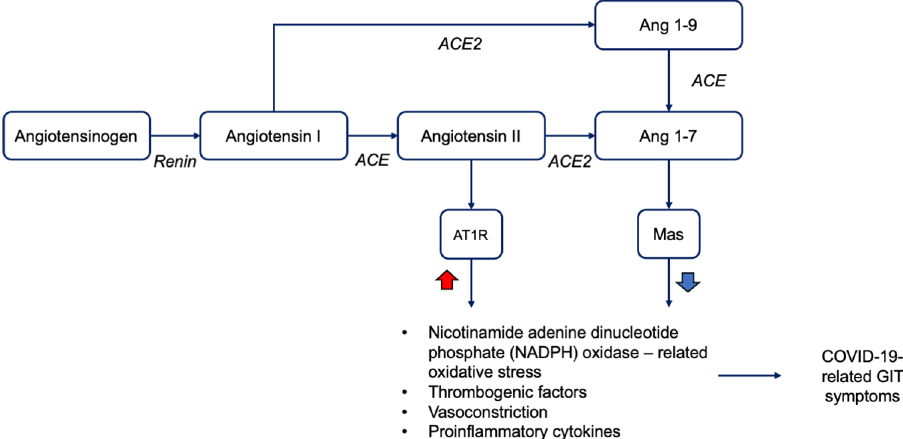
Figure 3. SARS-CoV-2 infection and dysregulation of ACE2/Ang (1 – 7)/Mas and ACE/Ang II/AT1R axis that are associated with GI tract symptoms. The inactive Ang I is converted into Ang II which produces its biological activities via its binding to AT1R. To maintain the homeostasis status, the catalytic activity of ACE2 converts Ang II to Ang 1-7 which has the opposite action of Ang II through its binding to Mas receptor. The invasion of SARS-CoV-2 to ACE2 causes an accumulation of Ang II and decreased level of Ang 1-7. This condition is linked to the increased interaction between Ang II and its receptor AT1R resulting in the hyperactivity of NADPH oxidase which is related to oxidative stress, massive production of proinflammatory cytokines, increased activity of thrombogenic factors and vasoconstriction. These events are eventually associated with the emergence of the COVID-19 GIT patients with COVID-19. 68 Interestingly, the rise in calprotectin is higher in patients who are also suffering from diarrhea 68 indicating that diarrhea in SARS-CoV-2 infection might be linked to intestinal inflammation. It has been proposed that intestinal inflammation might cause diarrhea by disturbing the homeostasis of gut microbiota. 69 Indeed, several inflammation-related diseases such as ulcerative colitis 70 and Crohn ’ s disease 71 are treated using probiotics to overcome gut dysbiosis.